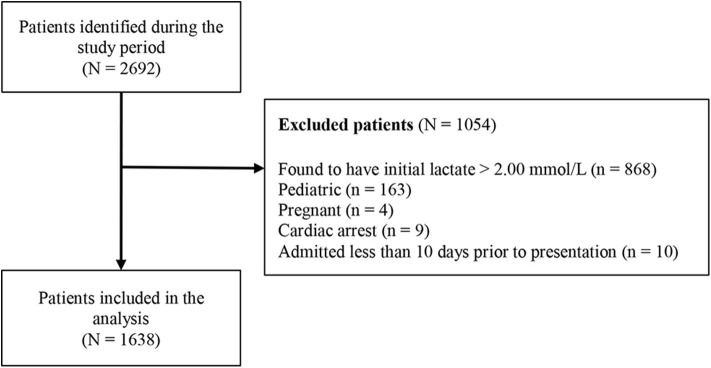
Flow diagram of patient selection.